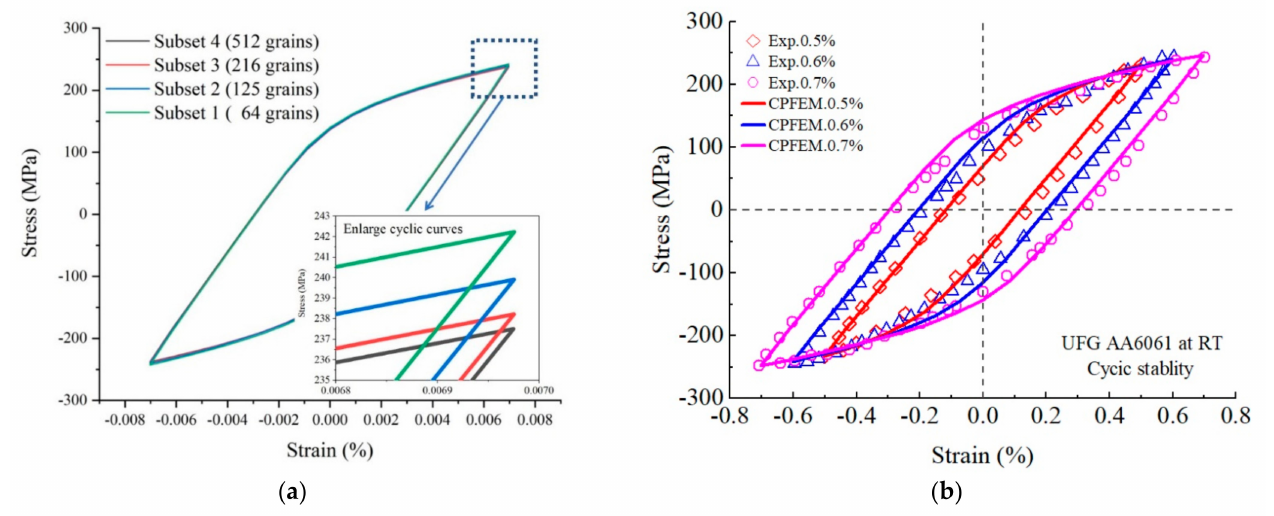
Figure 5. ( a ) Grain number sensitivity analysis; ( b ) The experimental and simulated hysteresis loop in terms of cyclic stability